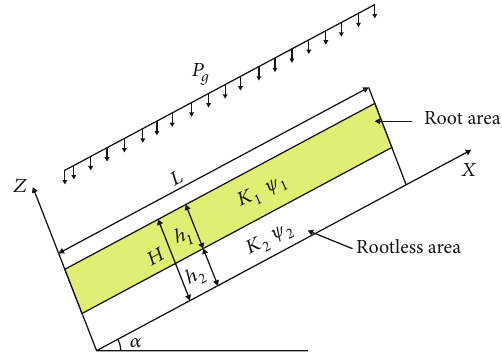
Figure 1: Schematic diagram of the hydraulic action of